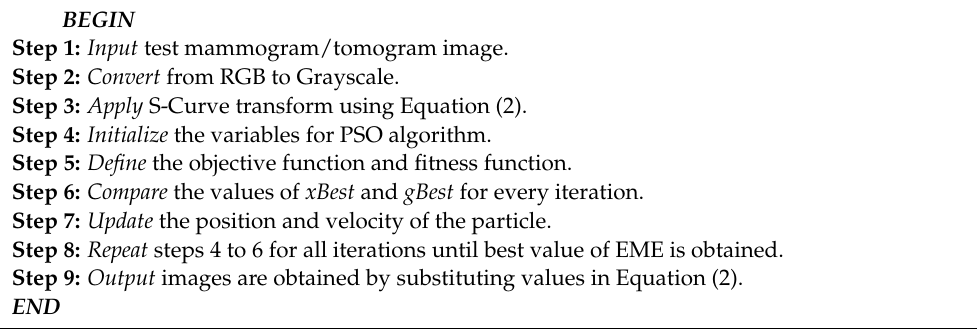
Algorithm 1: Procedural Steps for Optimized S-Curve Transform for Contrast